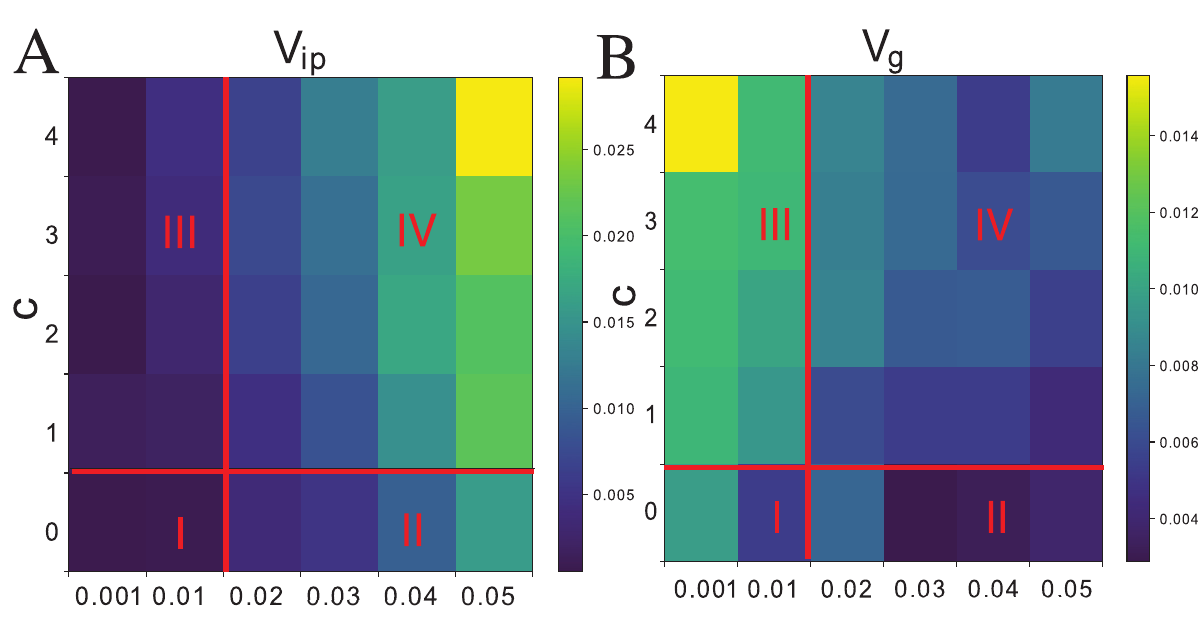
Fig 4. Dependencies of V ip and V g on the noise level σ and interaction strength c . V ip and V g for all output genes upon noise level σ (horizontal axis) and interaction strength c (vertical axis). The variance values for each parameter are displayed using color maps. The variance is computed by taking the average of 2500–3000 generations. The color maps indicate that the host–parasite interaction enhances V square are shown at their left and bottom edge (e.g., the bottom-leftmost square is the results for σ = 0.001 and c = 0) Each parameter regime is categorized into one of four regimes based on the values of V